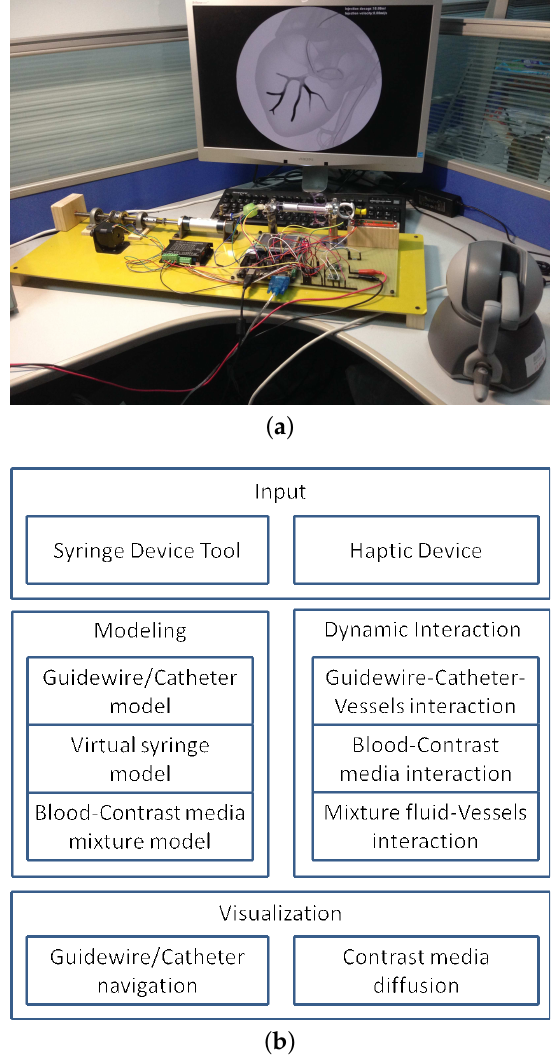
Figure 1. Overview of the proposed 3D interactive virtual angiography simulator and its key software components. ( a ): System overview; ( b ): Software